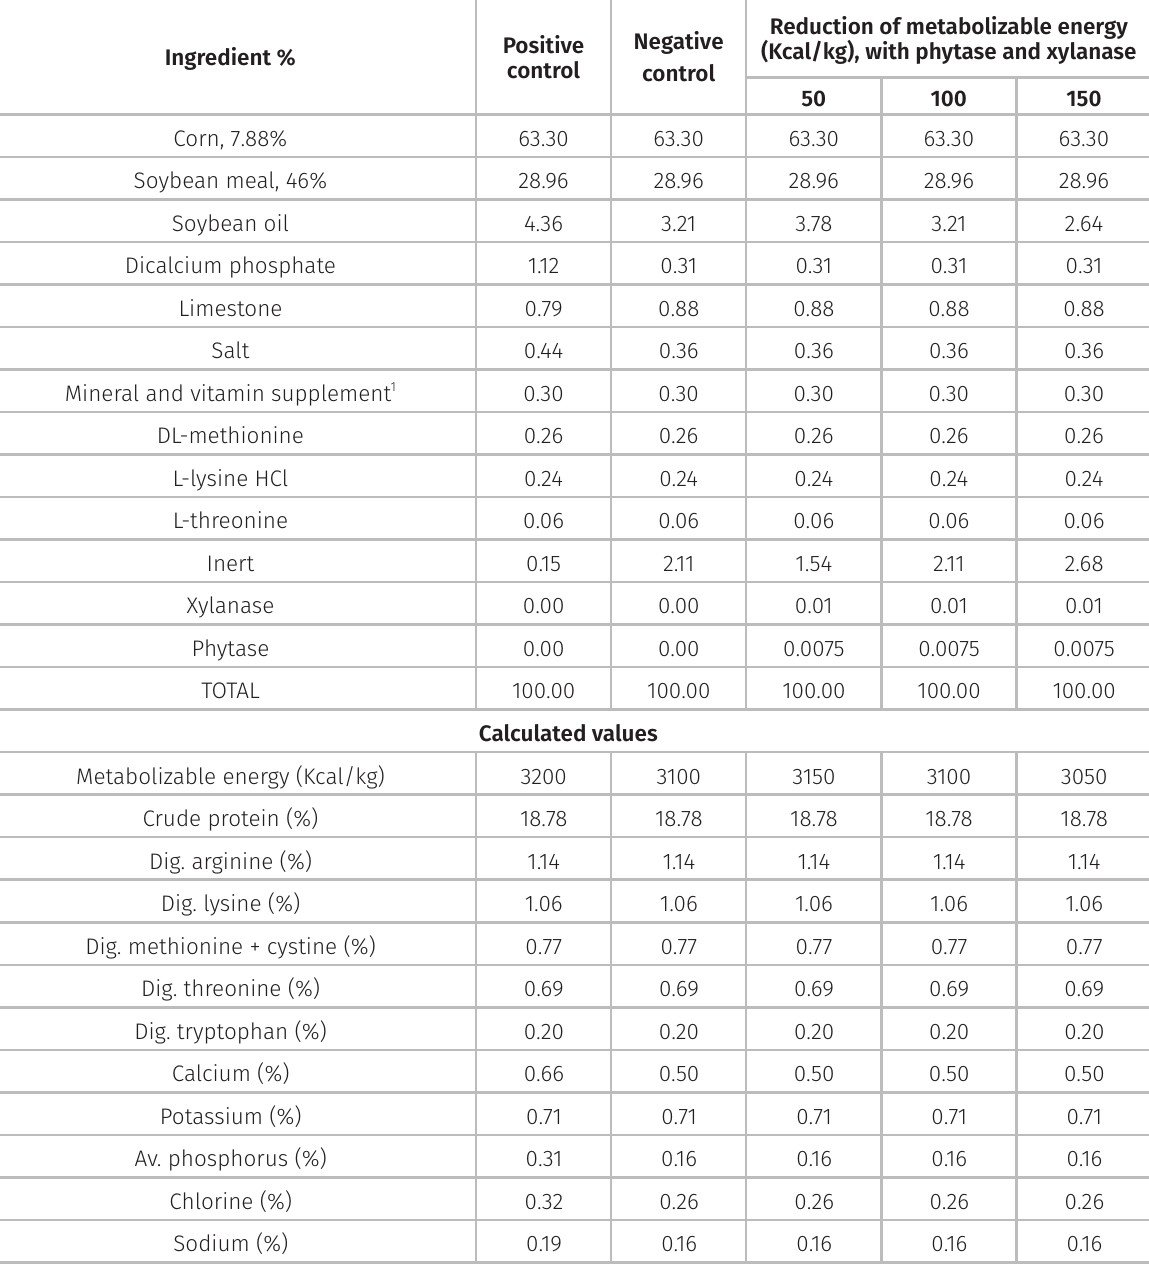
Table IV. Centesimal and calculated compositions of experimental diets for broilers in the pre-slaughter phase (34 to 42